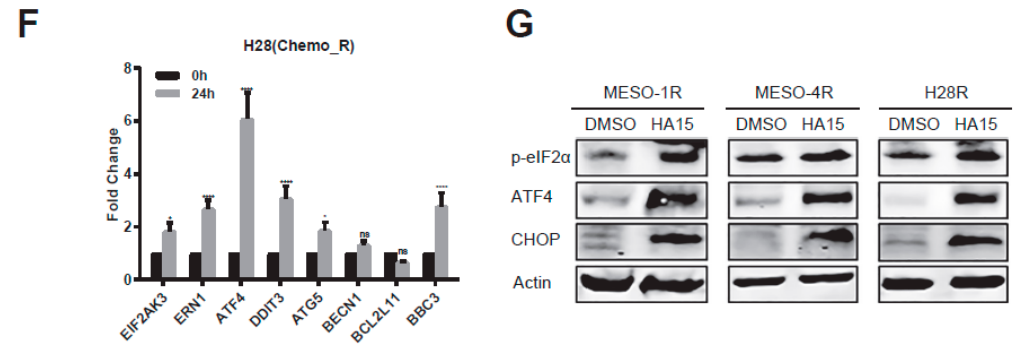
Figure 5. HA15 overcomes chemo-resistance in MPM cells. ( A , B ) Viability assay of parental (Chemo_S) and resistant (Chemo_R) MPM cells after treatment with cisplatin/pemetrexed or HA15 for 72 h. Data are presented as mean ± s.d. ( A ) representative result is presented ( n = 2). ( C ) Clonogenic assay of parental MPM cells (MESO-1, MESO-4, H28) and resistant MPM cells (MESO-1R, MESO-4R, H28R) treated with HA15 for 14 days. Representative images of three independent experiments ( n = 3) are shown. ( D – F ) qRT-PCR of resistant MPM cells after treated with HA15 (20 µM) for 24 h. Data are presented as mean ± s.d. ( n = 3). * p < 0.05, ** p < 0.01, *** p < 0.005, and **** p < 0.0001 by two-way ANOVA with Sidak’s multiple comparisons test. ( G ) Immunoblots of chemo-resistant MPM cells treated with HA15 (20 µM) or vehicle (DMSO) for 24 h. Protein quantification is shown underneath,